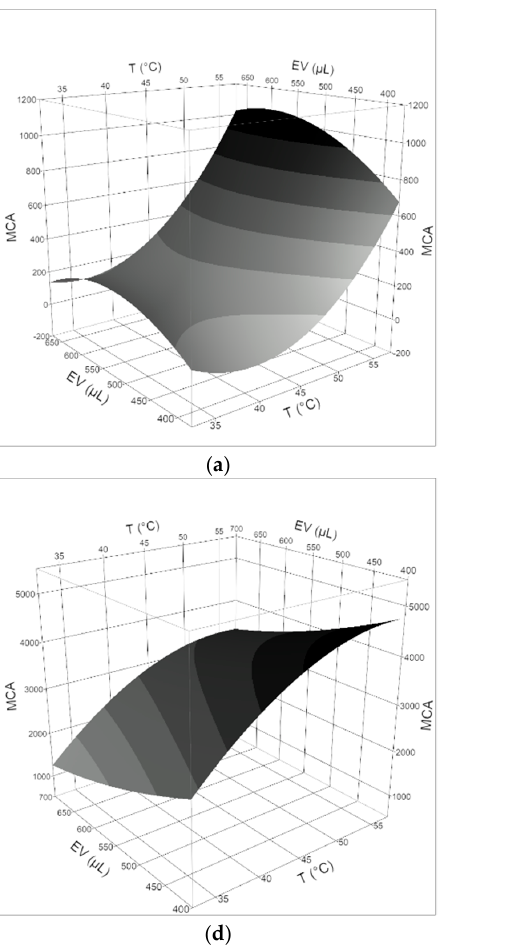
Figure 4. Response surface plots for the effects of ( a ) coagulant volume and temperature; ( b ) pH and T; ( c ) pH and coagulant volume, on the clotting activity of O. tauricum extract in cow’s milk; ( d ) coagulant volume and temperature; ( e ) pH and T; ( f ) pH and coagulant volume, on the clotting activity of commercial rennin in cow’s milk.